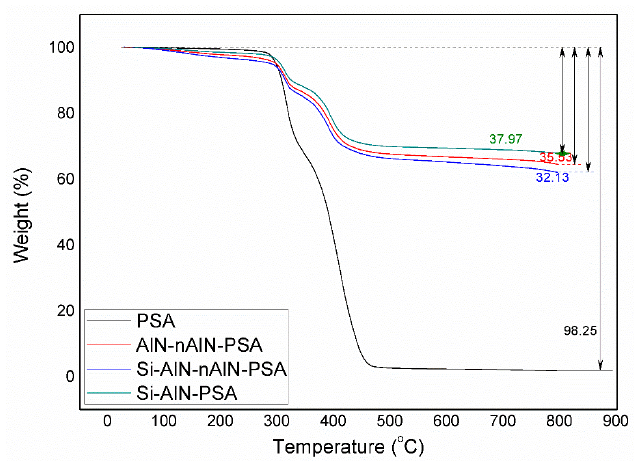
Figure5. TGAthermogramsofPSA, µ -AlN / n-AlN / PSA,Si- µ -AlN / n-AlN / PSA,andSi- µ -AlN / PSA,respectively. Figure 5. TGA thermograms of PSA, µ-AlN/n-AlN/PSA, Si-µ-AlN/n-AlN/PSA, and Si-µ-AlN/PSA, respectively. Table 2. Thermogravimetric analysis data of PSA, µ -AlN / n-AlN / PSA, Si- µ -AlN / n-AlN / PSA, and Si- µ -AlN / PSA. Table 2. Thermogravimetric analysis data of PSA, µ-AlN/n-AlN/PSA, Si-µ-AlN/n-AlN/PSA, and Si-µ- AlN/PSA.